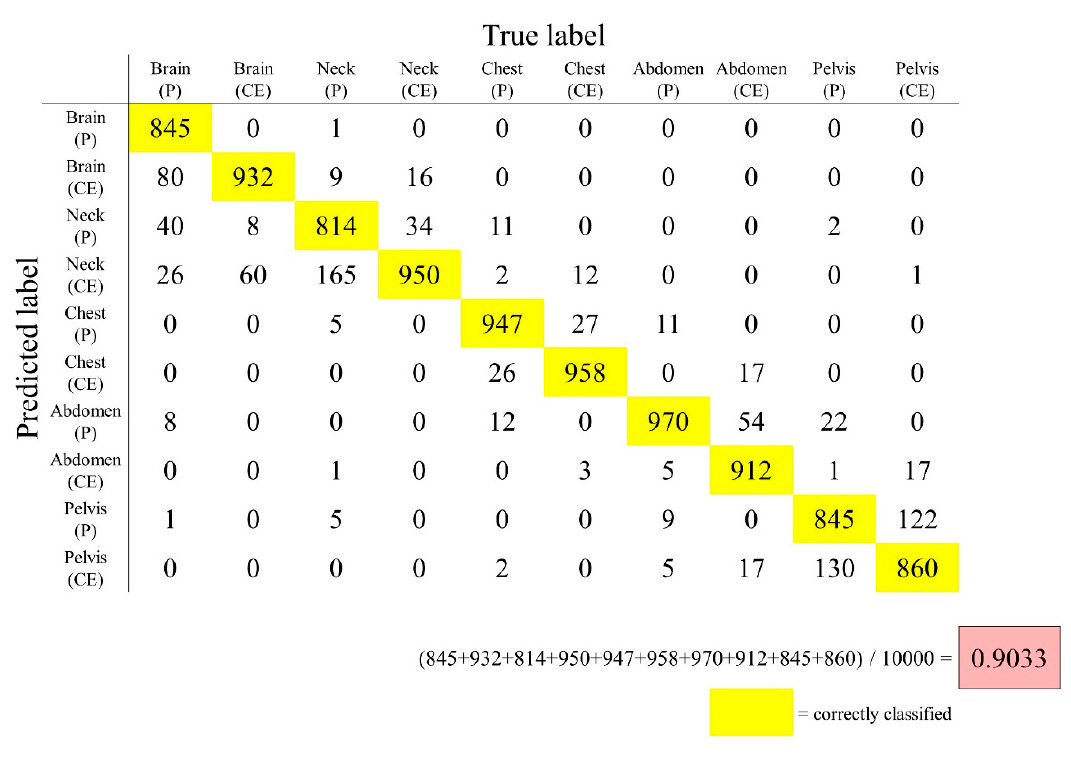
Figure 5. Confusion matrix for evaluating the overall accuracy, which was calculated using the validation dataset A with 50 K dataset.